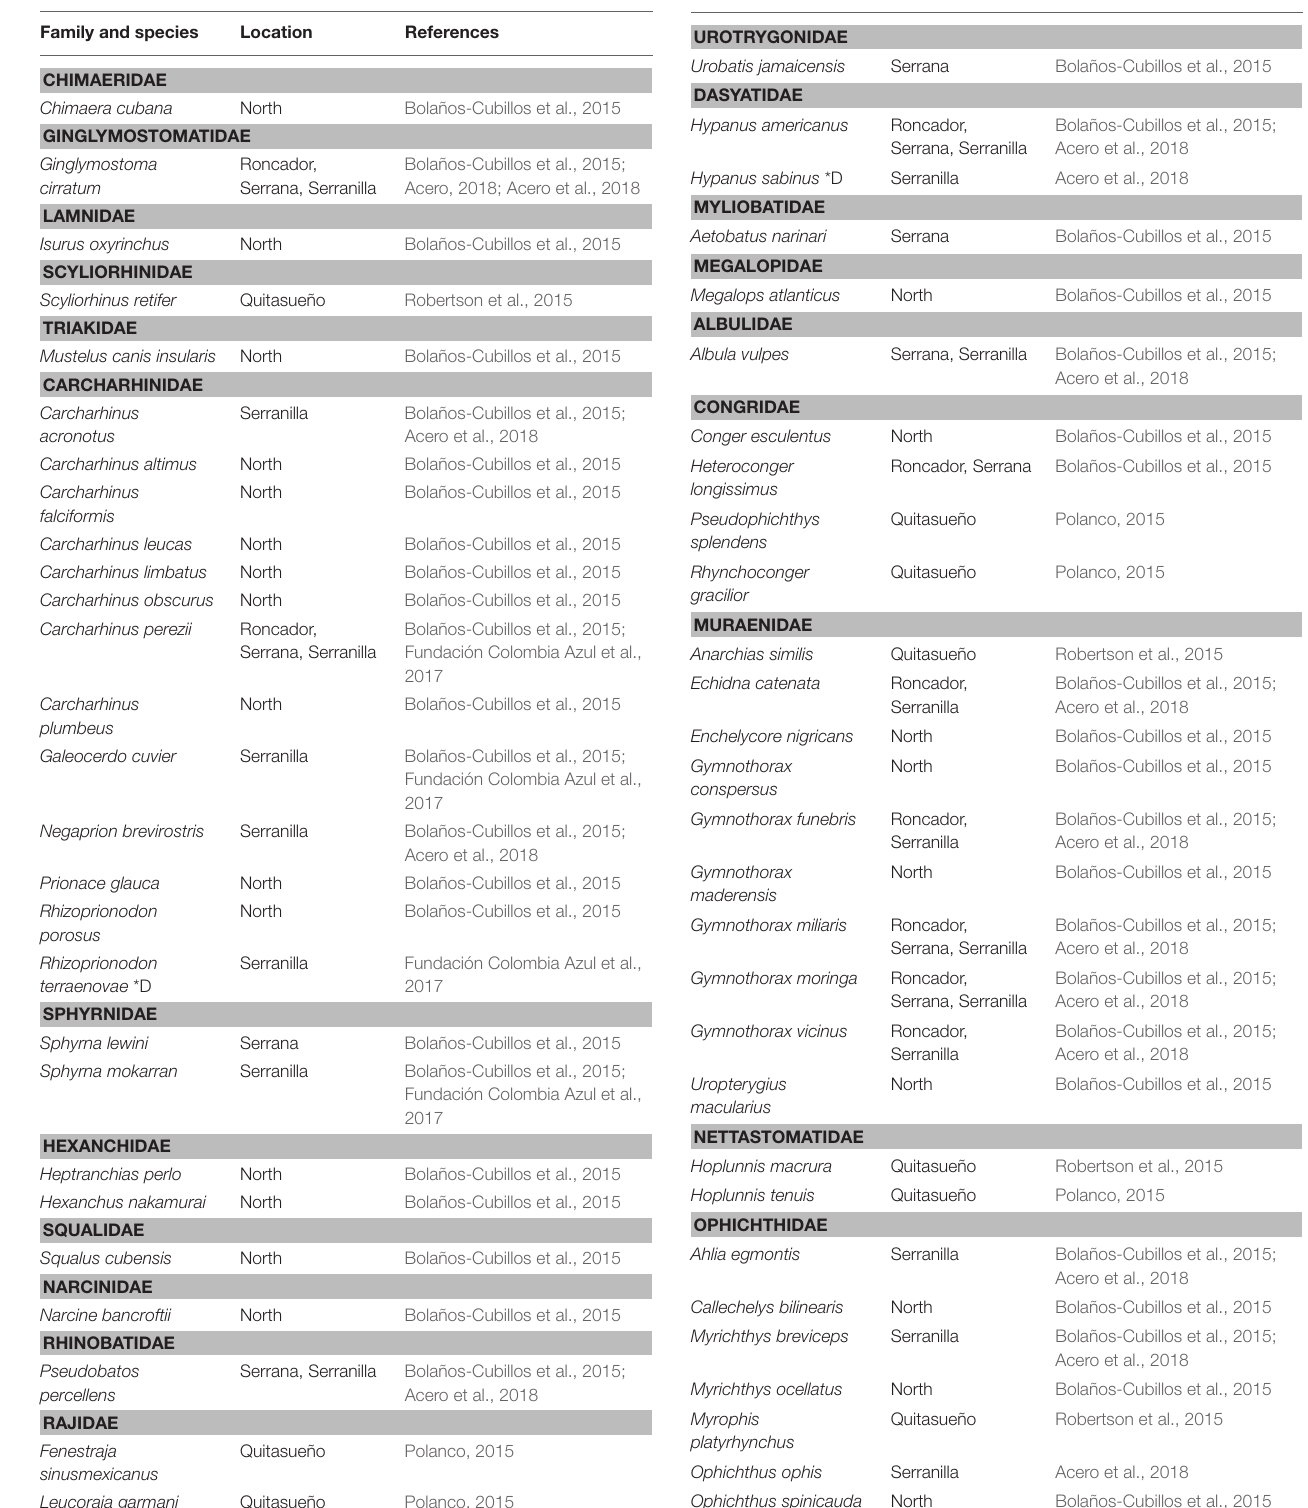
TABLE 1 | Inventory of the species observed in three of the northern islands of the Reserve Roncador, Serrana and Serranilla with some additional records from Quitasueño and the northern water